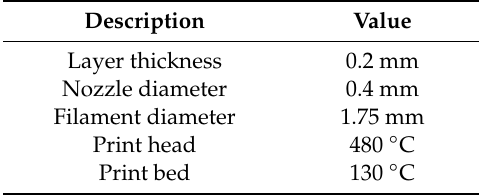
Table 1. The fabricating parameters of the FFF 3D printer.